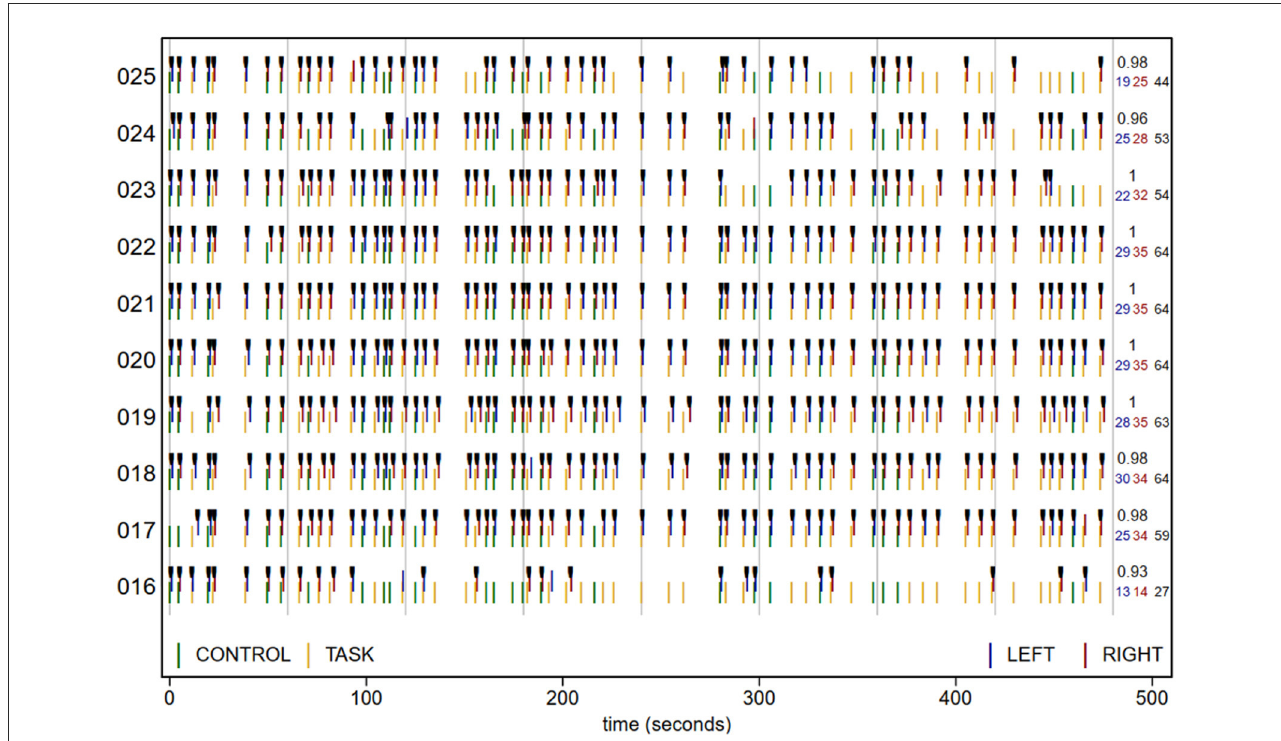
FIGURE3 Task trial onset time (colored by trial type), response (at onset + reaction time), and accuracy (black ticks) for 10 participants. Vertical gray lines are at 1-min intervals. Numbers at right margin give the number of LEFT (blue) and RIGHT (red) responses, total responses (black; 64 if no trials lacked a response), and proportion correct of the trials with a response. sub-016 responded correctly to all trials in the 1st min, but then had more and more trials without a response, suggesting that they became less attentive as the run progressed. sub-025 was also excluded due to criterion C, and while their strings of no-response trials did not reach the 5-trial threshold until the last minute of the run, they missed noticeably more trials in the second than first half of the